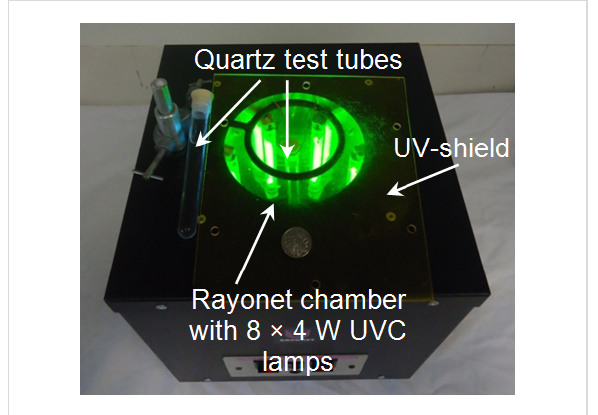
Figure 1: Rayonet chamber reactor (RMR-600; Southern New England) with quartz test tubes. A 10 AU-cent coin is shown for com- parison.